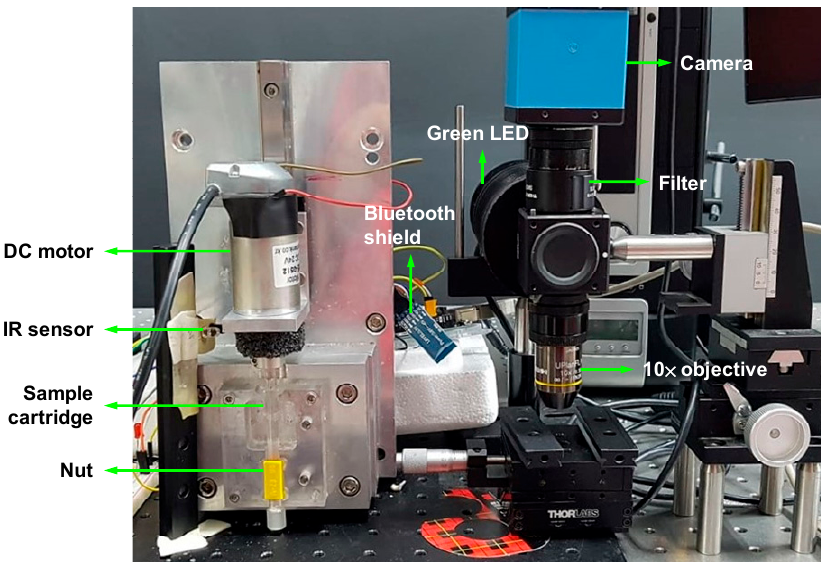
Figure 4. Experimental setup for nut-and-bolt microfluidic mixing and the detection system.